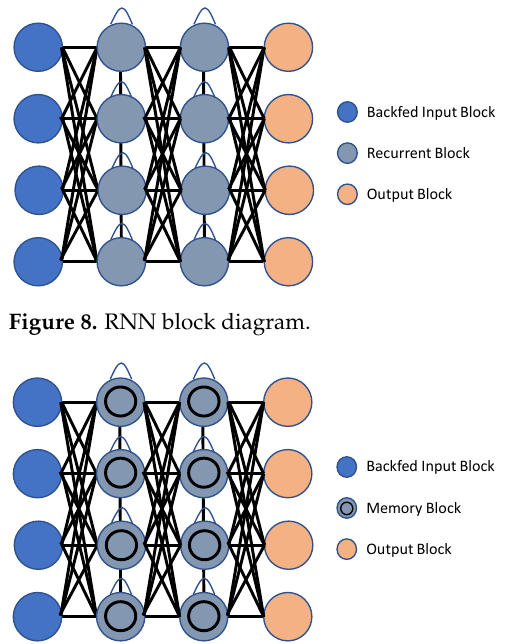
Figure 9. LSTM block